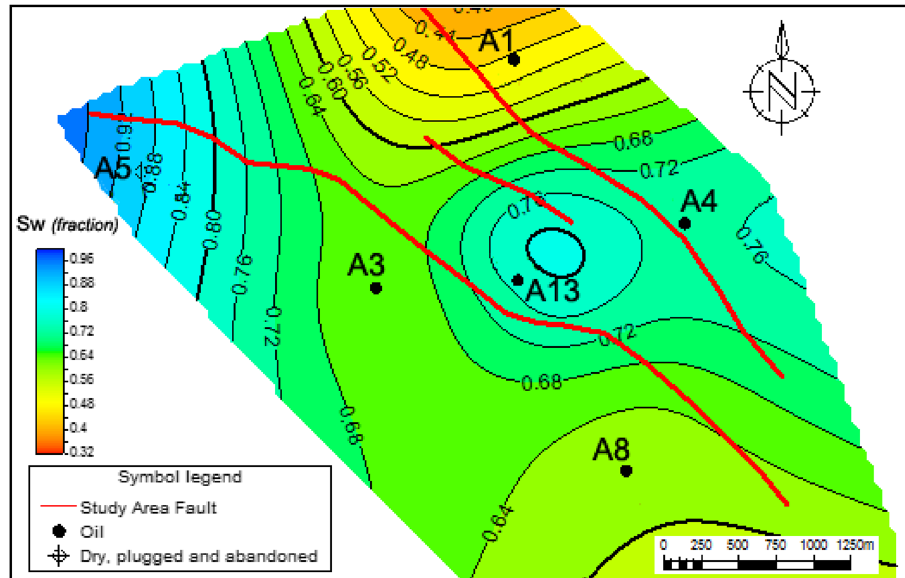
Fig. 15 Average water satura- tion ( S w ) of the Facha reservoir in the study